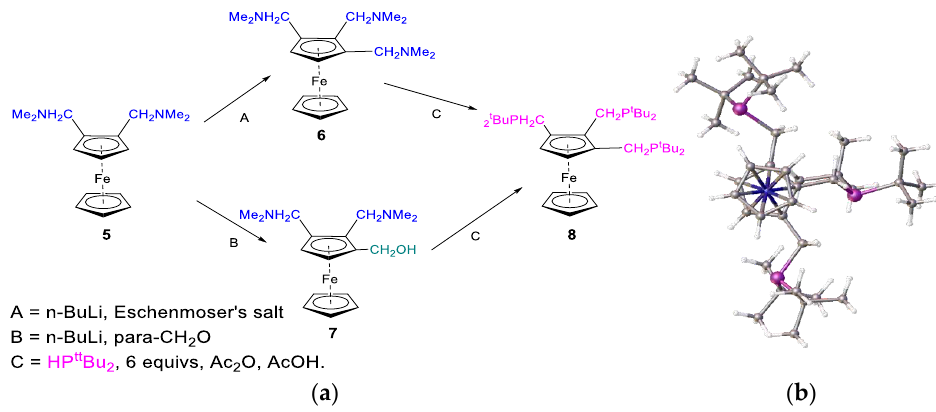
Figure 7. ( a ) Synthetic route to 1,2,3-tris-(tri- t butylphosphino)ferrocene, 8 , and ( b ) crystal structure of compound 8 [4,5].